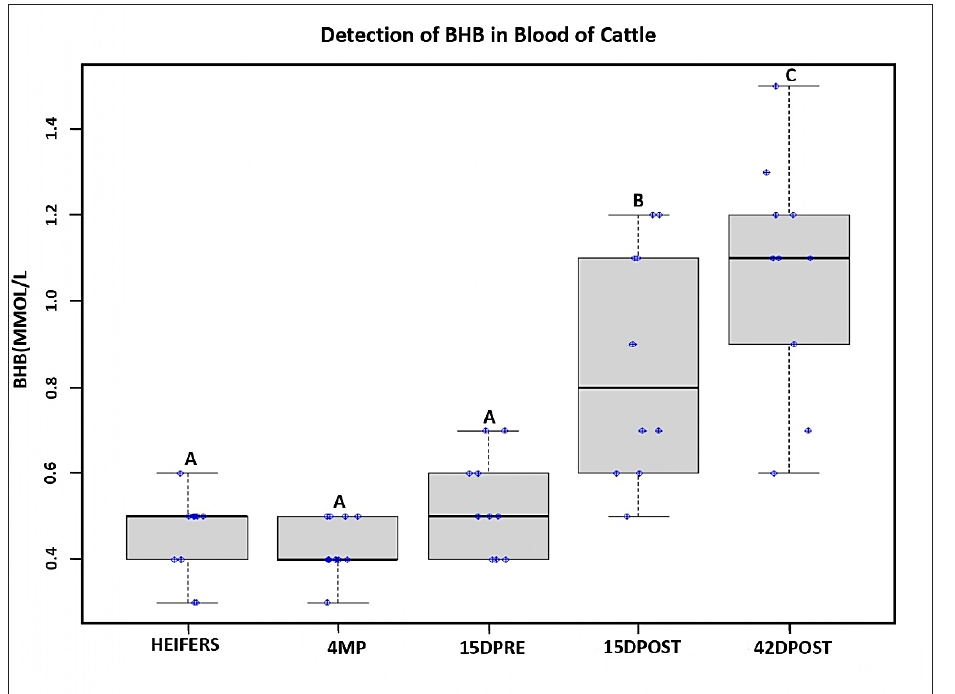
Figure-1: Detection of β -hydroxybutyrate in blood of